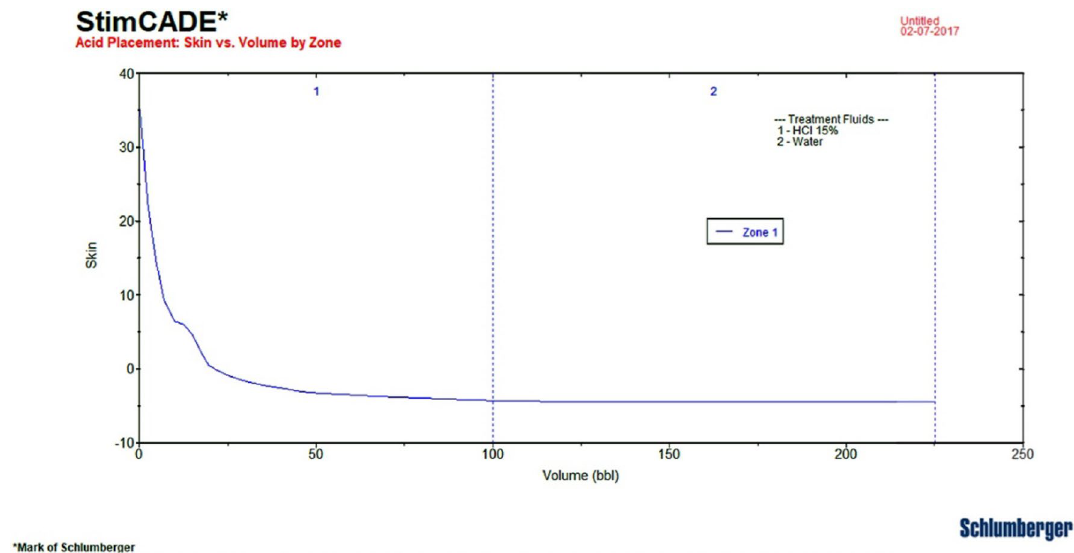
Fig. 7 Skin factor changes regarding volume of acid injection